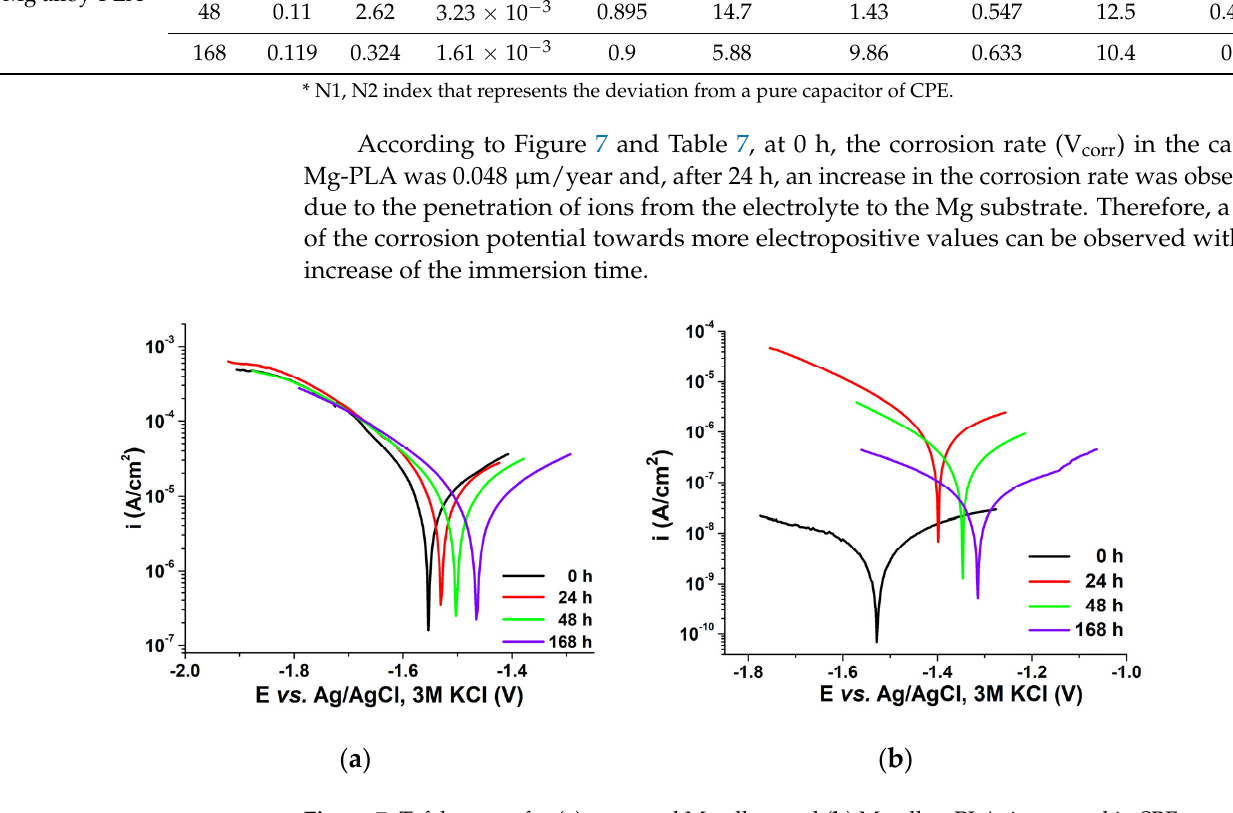
Figure 7. Tafel curves for ( a ) uncoated Mg alloy, and ( b ) Mg alloy-PLA, immersed in SBF, over time. Table 7. Tafel parameters for samples of uncoated Mg alloy, and Mg-PLA alloy. Sample